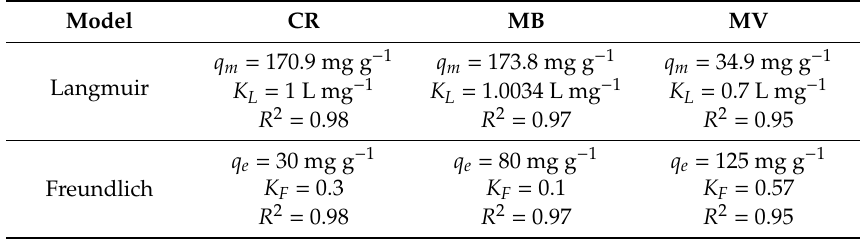
Table 5. Parameters of the Langmuir and Freundlich isotherms for dye adsorption on Cu 3 (BTC) 2 · 2H 2